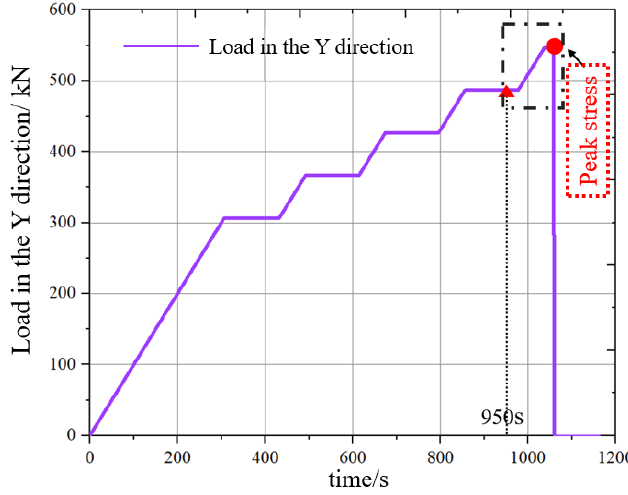
Figure 12. Load ‐ time curve of sample A ‐ 0.